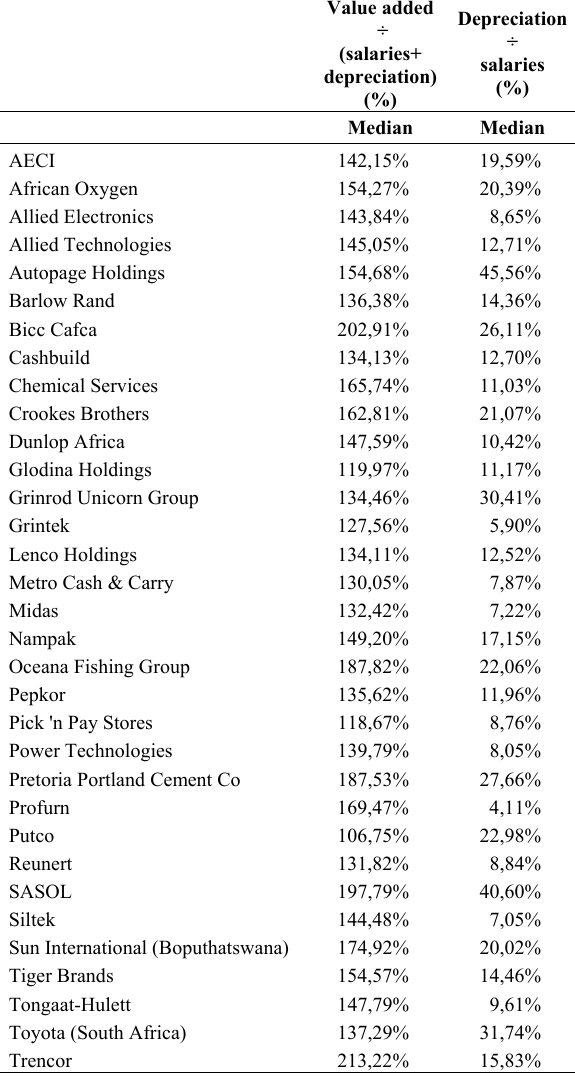
Table 4: Efficiency ratios